Question: Judging by this figure, is the value going up or going down?
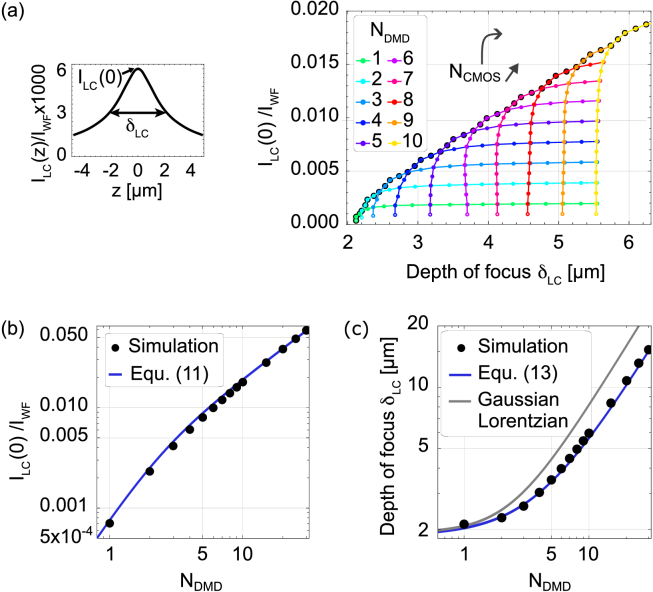
Answer: increasing